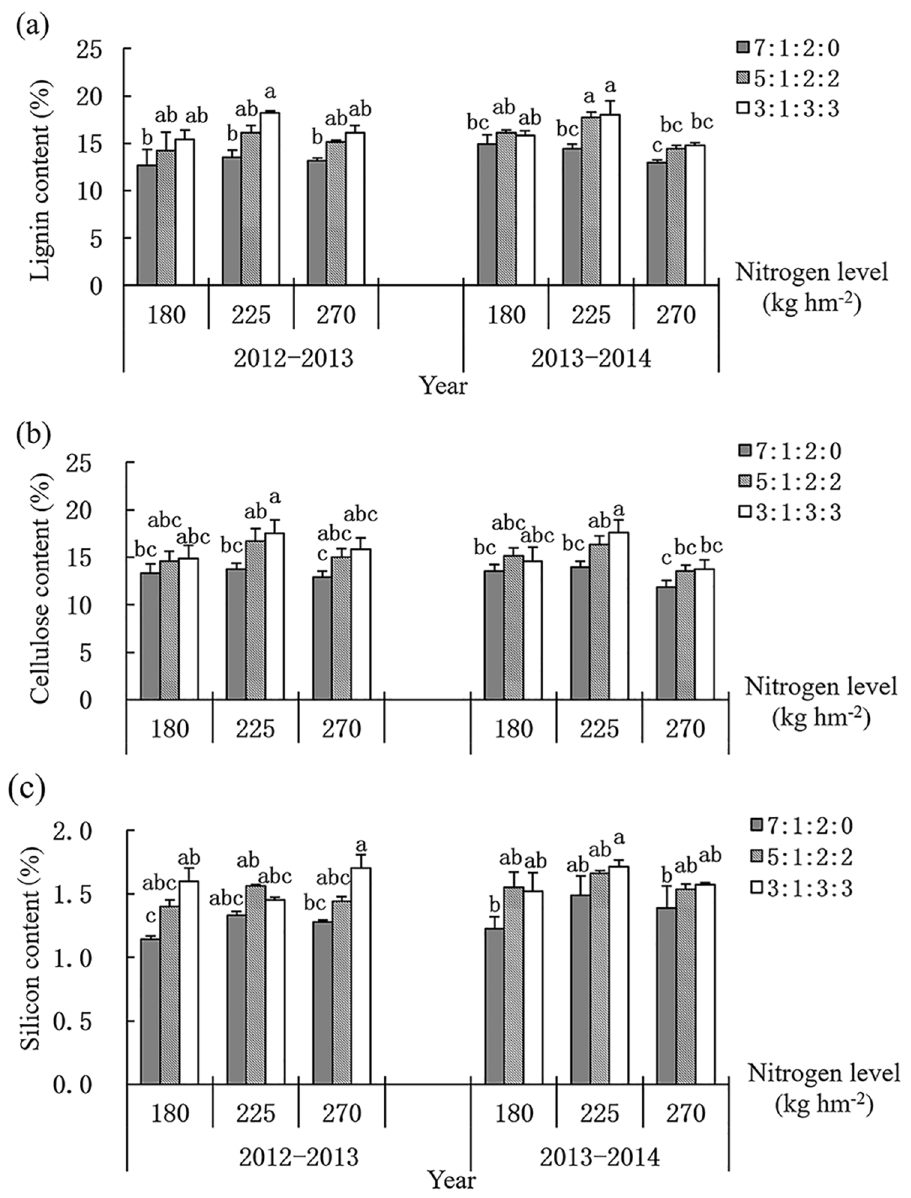
Fig 3. Effect of nitrogen levels and ratios on lignin (a), cellulose (b) and silicon (c). Different letters on the culm mean significantdifference amongthe treatments at P < 0.05 as determinedby the LSD test. The test was conductedseparately betweenthe two